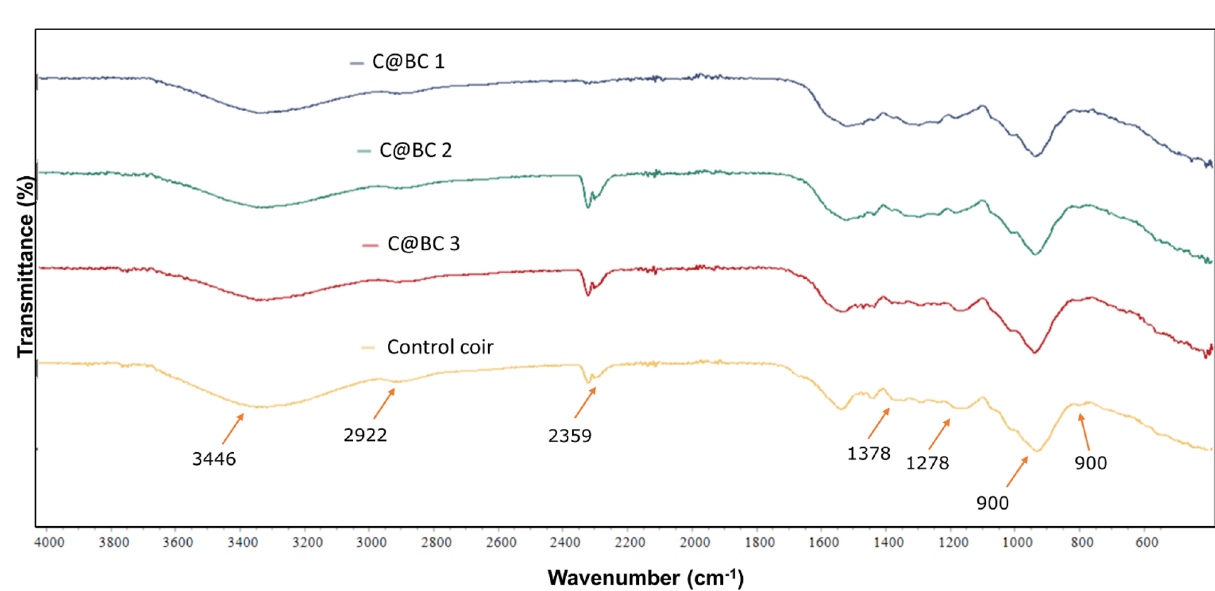
Figure 7. FTIR analysis (4000 ‒ 500 cm ‒ 1 ) of control coir, C@BC 1, C@BC 2, and C@BC